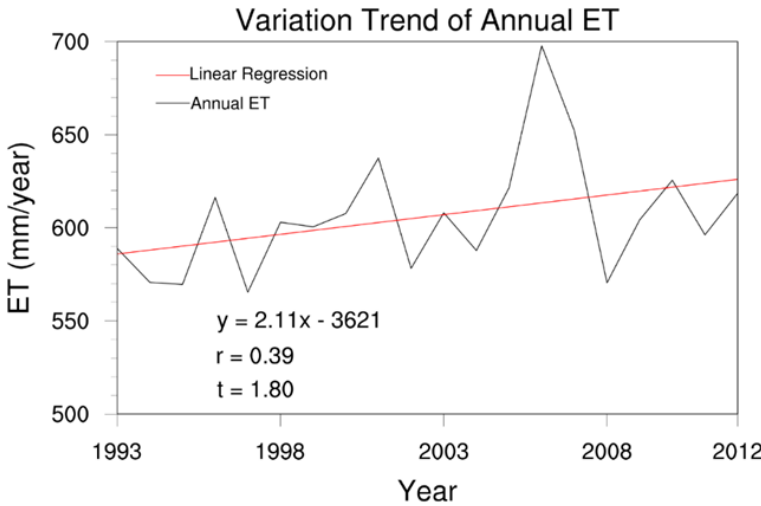
Figure 8. The variation trend of annual evapotranspiration (ET) from 1993 to 2012.